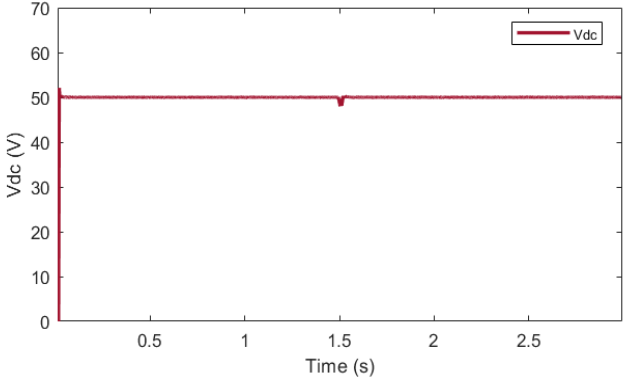
Figure 13. PV, DC load, AC load, supercapacitor, and battery power for change in irradiance.